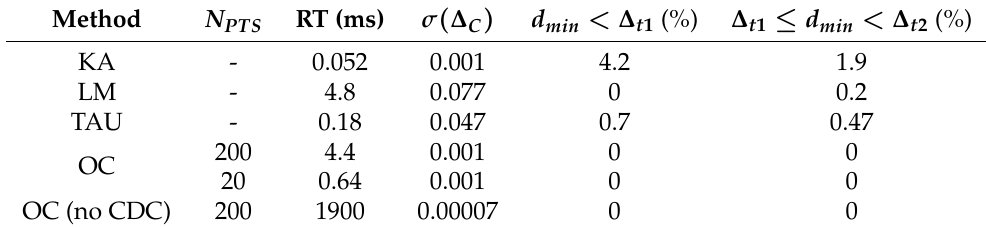
Table 2. Fitting results for case study 1.